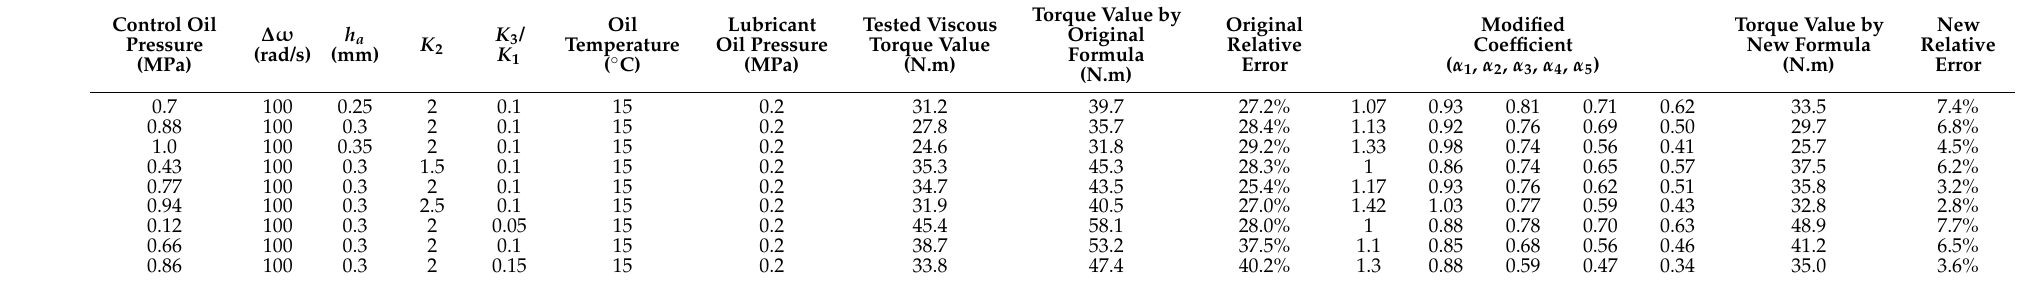
Table 3. Experimental data related to the overall viscous